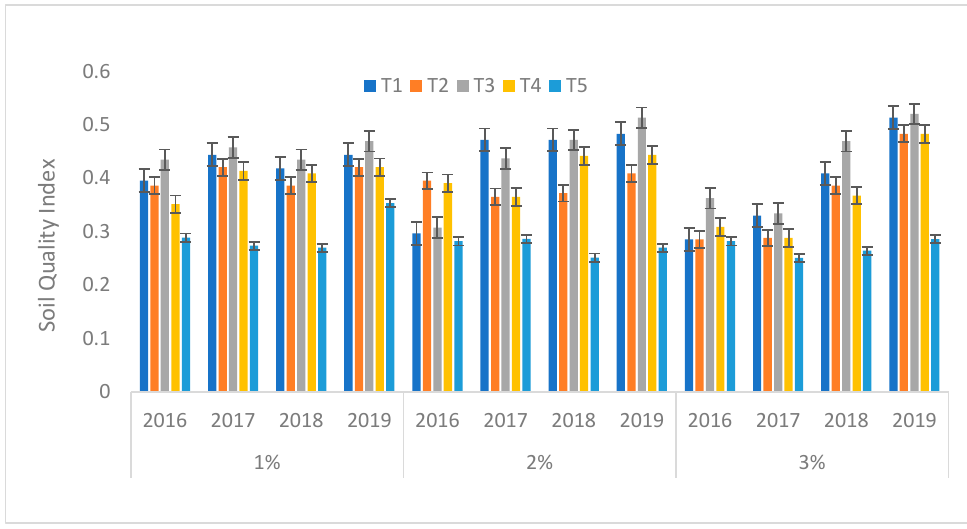
Figure 5. Soil quality index for treatments across variable slopes (1–3%). T1, the top and bottom Stylosanthes strip; T2, only the bottom strip of Stylosanthes ; T3, the top and bottom Brachiaria strip; T4, only the bottom strip of Brachiaria ; and T5, the control.